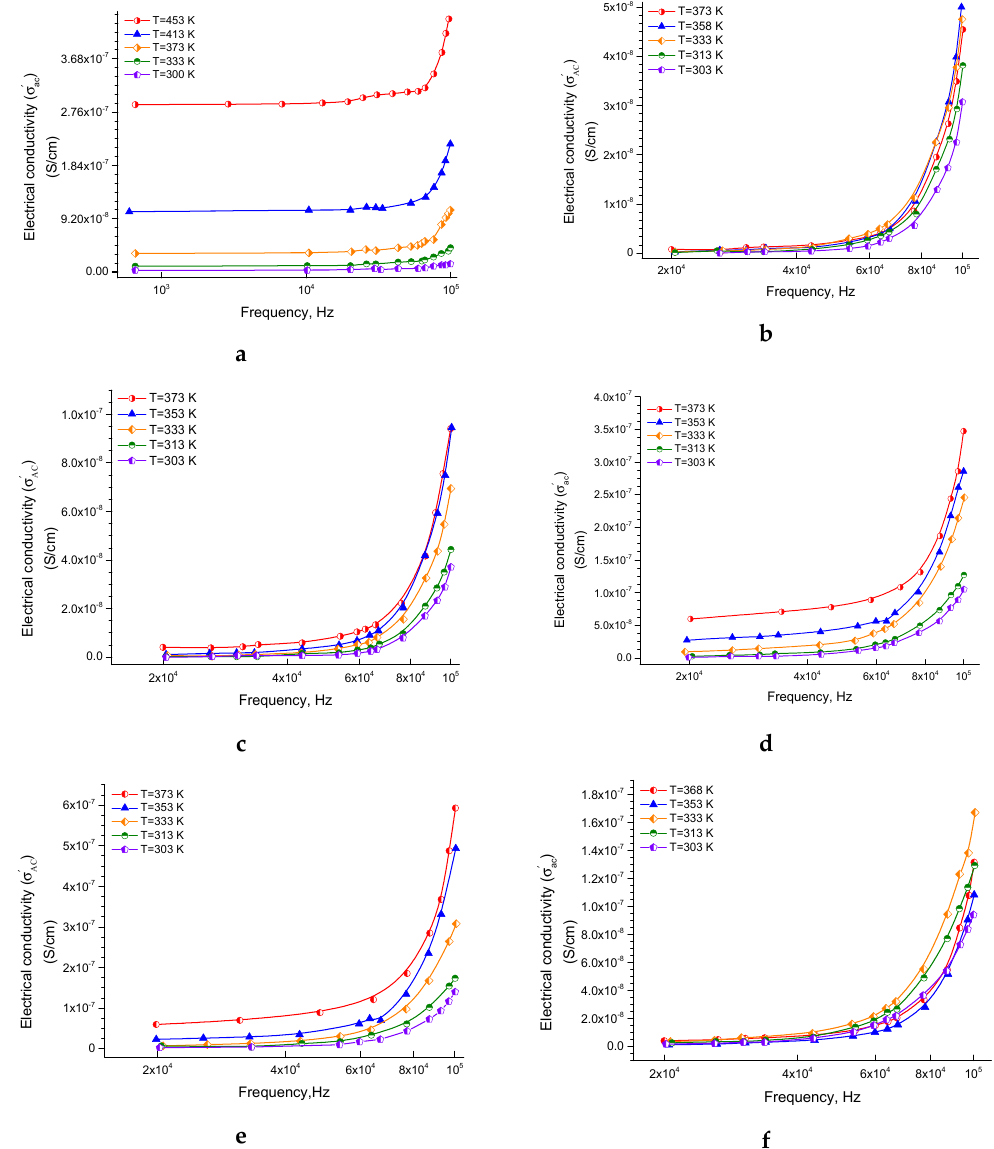
Figure 2. The σ ac ´ electrical AC-conductivity as a function of the frequency of ferrite sintered at 1473K ( a ), pure epoxy ( b ), 20% ferrite + 80% epoxy ( c ), 30% ferrite + 70% epoxy ( d ), 40% ferrite + 60% epoxy ( e ), 50% ferrite + 50% epoxy ( f ).